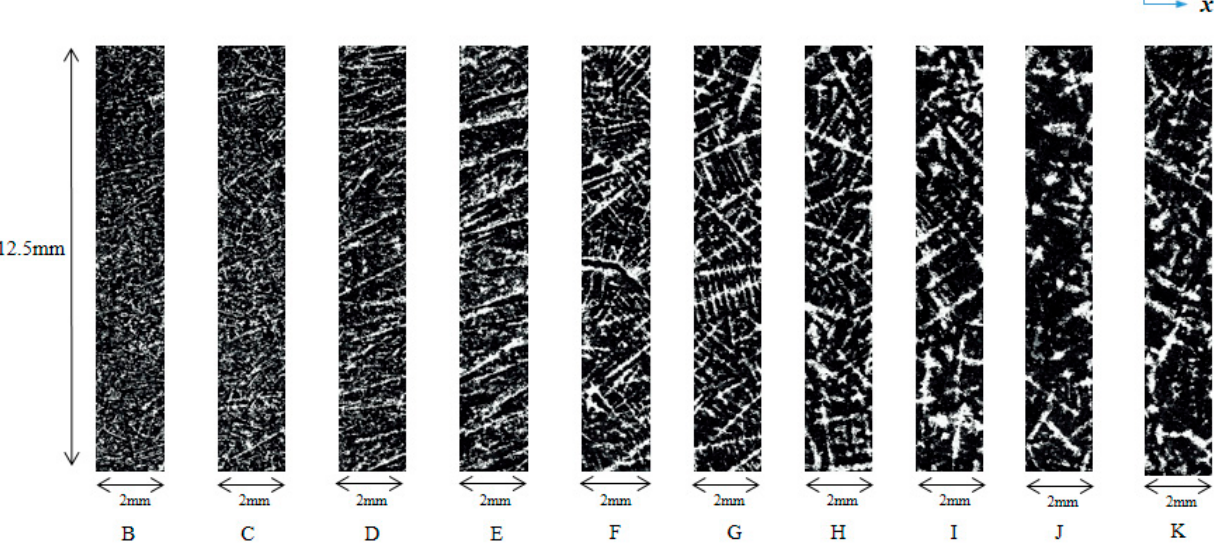
Figure 23. Macrostructures at 10 positions (B–K) in the inner curve side under 20 °C whose distances to the bloom edges are 3, 5, 10, 20, 30, 40, 50, 60, 70, and 80 mm, respectively. (The location relative to the measuring line is marked by a red rectangle in Figure 4.)